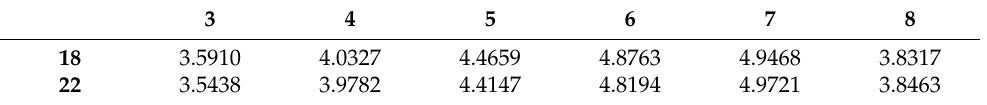
Table 5. The ef f ( j , k ) value of the Fejer–Korovkin family (wavelet length 18–22).